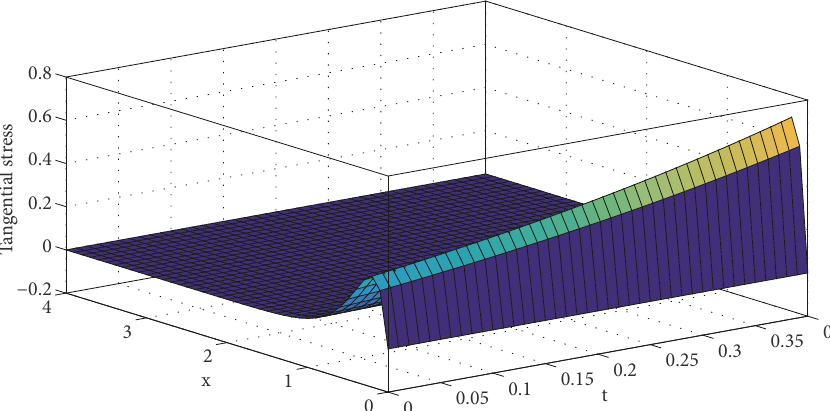
Figure 16: Profile of tangential stress distribution at 𝑛 = 1.0 , 𝐻 0 = 10 5 , and Ω = 0.5